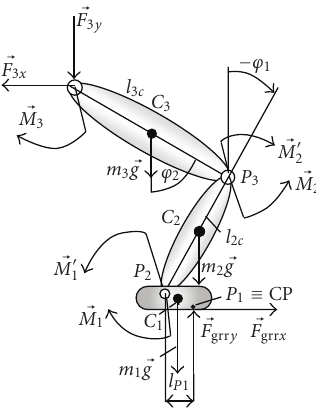
Figure 8: Planar partial free-body diagram for the right standing